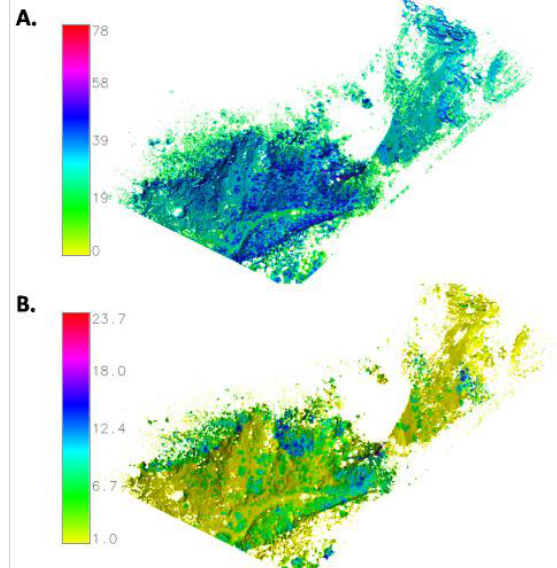
Figure 8. A.) vegetation density mapping (n° of points belonging to vegetation/m 2 B.) canopy height distribution (meters).